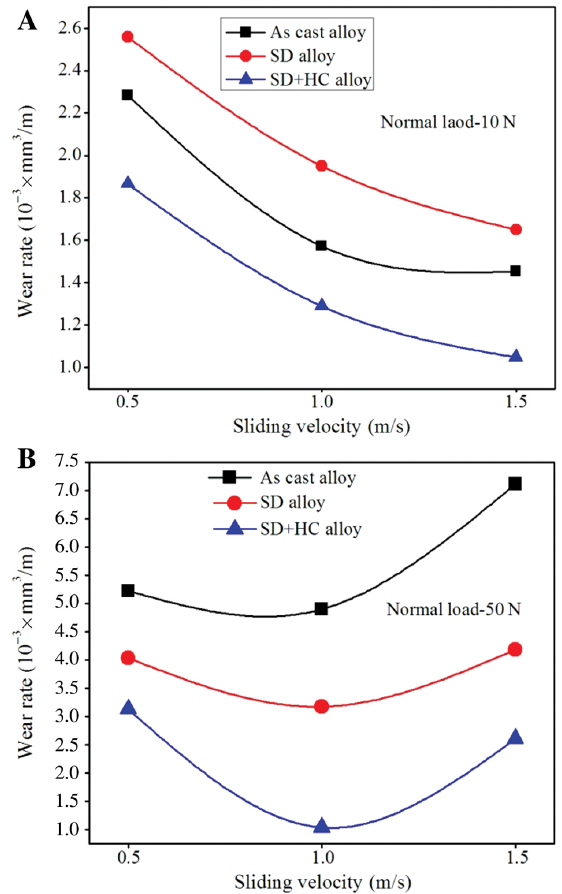
Figure 6: Variation of wear rate with sliding velocity at load of (A) 10 N and (B) 50 N. The variation of wear rate with sliding speed at a load of 10 N is shown in Figure 6A. It is observed that at the low load, wear rate decreases with an increase in the sliding velocity and the as-cast alloy the wear rate is high as compared to that of the SD alloy. In addition, the SD+HC alloy shows less wear rate compared to AC and SD alloys. Figure 6B shows the wear rate of the as-cast SD and SD+HC alloys under different sliding velocities at a load of 50 N. It can be observed from Figure 6B that the wear rate follows a negative exponential pattern when the sliding velocity increases. This is due to the fact that at low sliding velocity more time is available for the formation and growth of micro welds, which increases the force required to shear off the micro welds to maintain the relative motion, due to which wear rate increases. As the velocity increases, there is less residential time for the growth of micro welds leading to less wear rate. With a further increase in the sliding speed (1.5 m/s) there is increase in the frictional force, frictional temperature, and the alloy becomes softer. Consequently intimate contact between the wearing surface and the rotating disc increases, results in a higher wear rate. Figure 7 shows the coefficient of friction (COF) as a function of the applied load. It can be seen that the COF decreases gradually with an increase in load for all the investigated alloys and the SD+HC alloy shows a low COF as compared to the AC and SD alloys. The value of COF at a higher load is about one half of its value at a low load in the load range investigated. It is suspected that at a low load, more time is available for the formation and growth of asperity junctions in the contact regions, which increases the force required to shear off the junction to maintain the relative motion, hence the high coefficient of